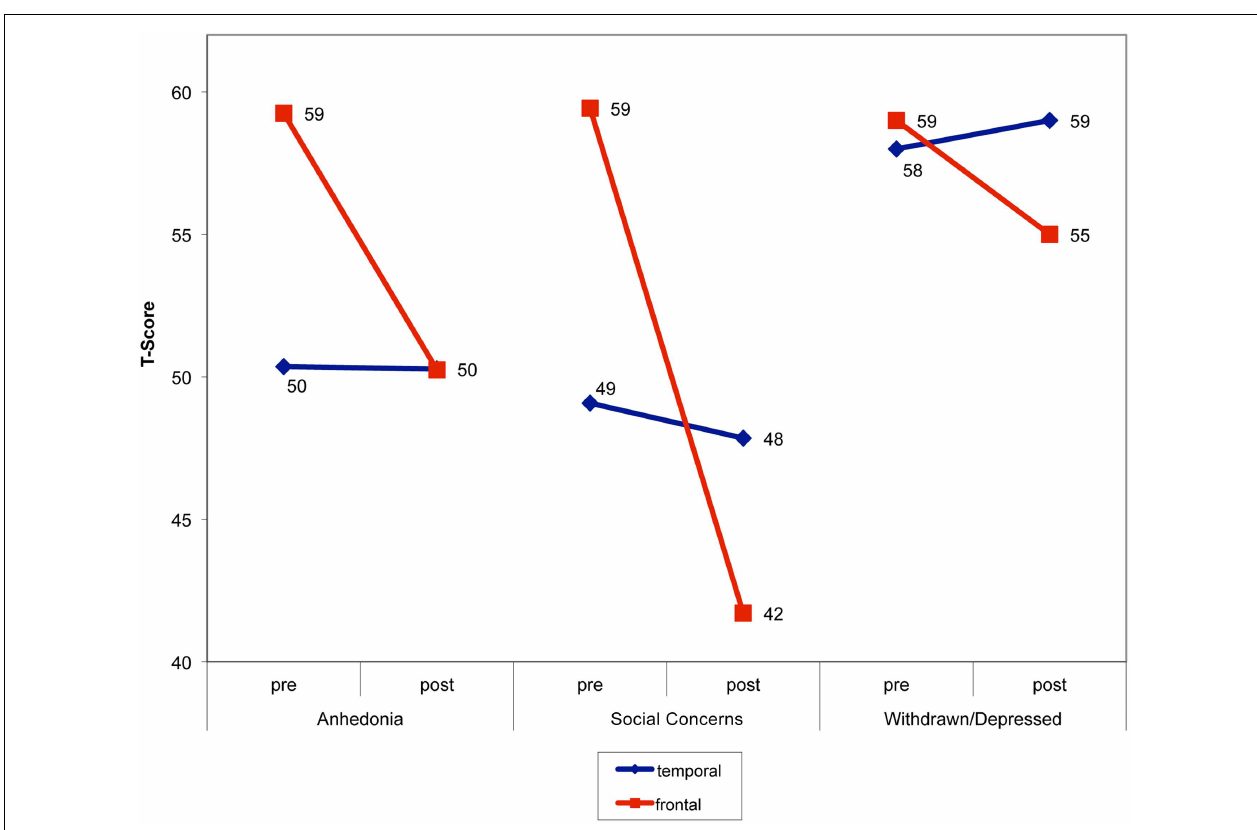
FIGURE 1 | Change in mood, anxiety, and behavior in children following left-sided surgery, with children who underwent frontal resections showing significant improvement .